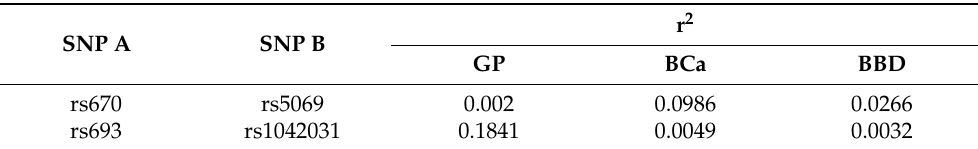
Table 3. Linkage disequilibrium analysis for general population, breast cancer, and benign breast disease groups.